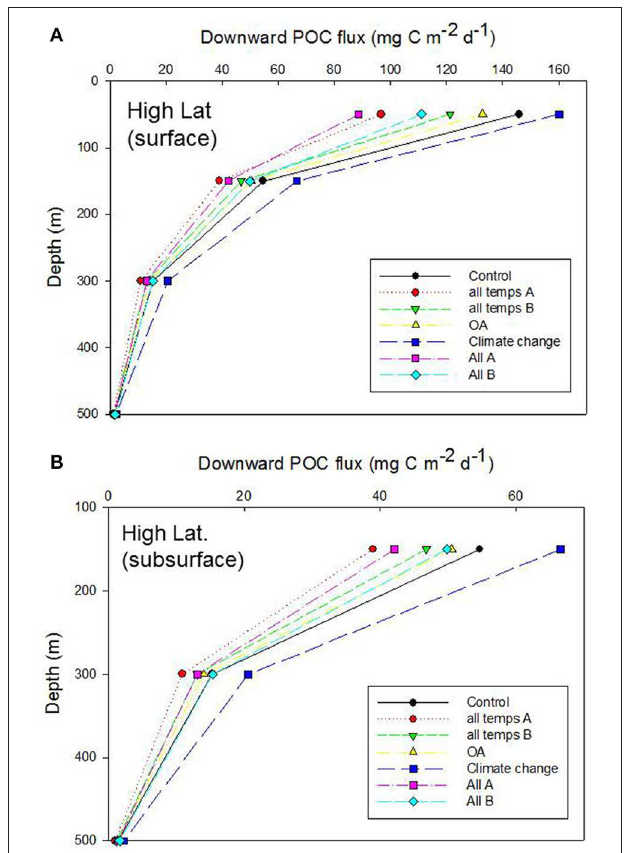
FIGURE 6 | Vertical profile of projected POC flux for the control run, high latitude case, for (A) surface and (B) subsurface processes. Additional simulations represent the cumulative effect of alteration of individual properties that influence the functioning of the biological pump: “all temps” denotes all the temperature-mediated individual processes described in Table 6 (“A” and “B” are runs in which the mesozooplankton trophic transfer efficiency for surface waters is decreased and increased, respectively, relative to the control); OA denoted all OA-mediated individual processes; “Climate change” is the alteration of more complex processes (NPP, DVM, and deoxygenation) which are controlled by multiple factors; “All” is the cumulative effect of altering all of the temperature-, OA- and climate-change- mediated individual factors (“A” and “B” are as described earlier).